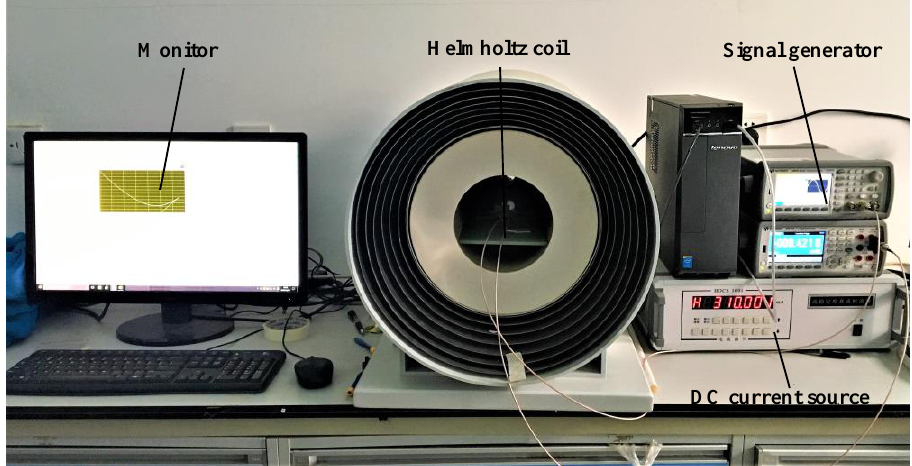
Figure 7. Experimental set up to measure the output of the magnetic field sensor. The outside of the Helmholtz coil is an 8-layer metal shield that allows the sensor to be undisturbed by the external magnetic field.